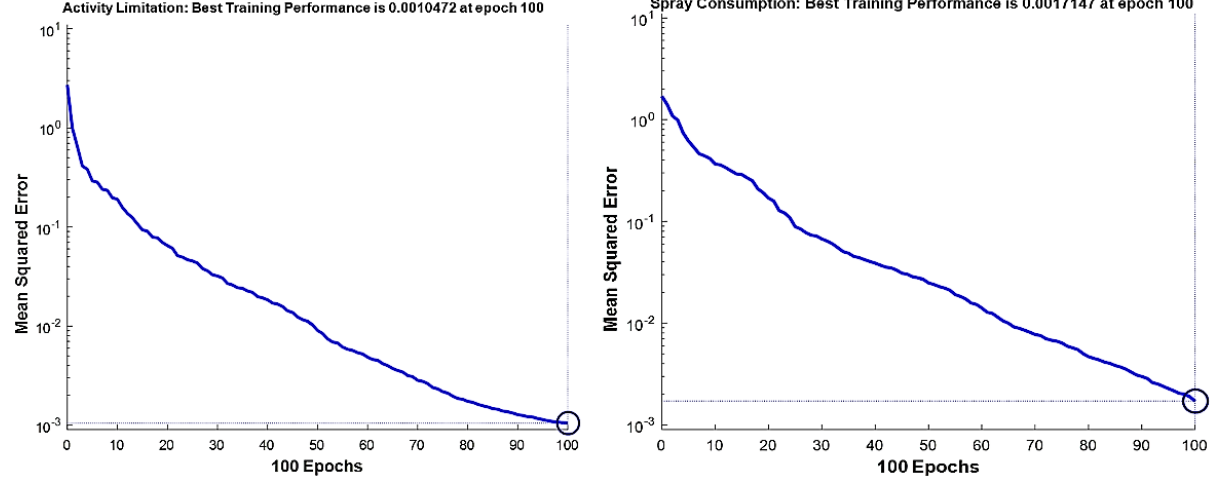
Figure 7. Training performance of the genetic algorithm–modified neural network for C sativus L supplement effects on the asthma clinical symptoms: activity limitation (left), salbutamol inhaler use